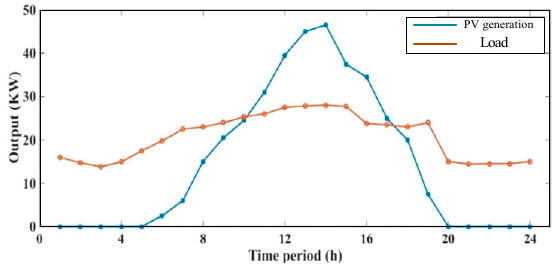
Figure 12. The output of PV generation and load.